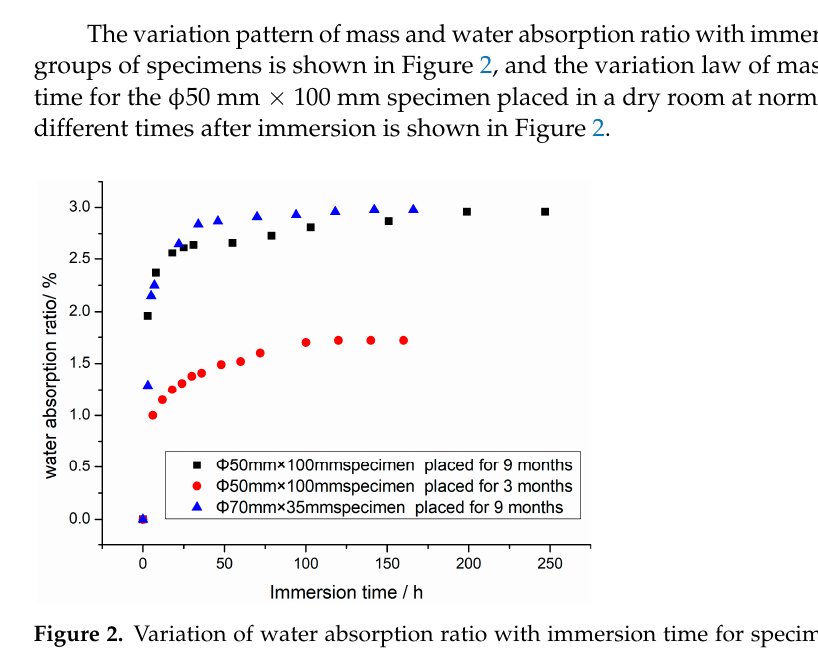
Note: 1 Relative water absorption ratio = (water absorption mass of specimen/total water absorp- tion mass of specimen at saturation) × 100%. 2 Relative saturation ratio = (water mass of speci- men/water mass of specimen at saturation) × 100%.